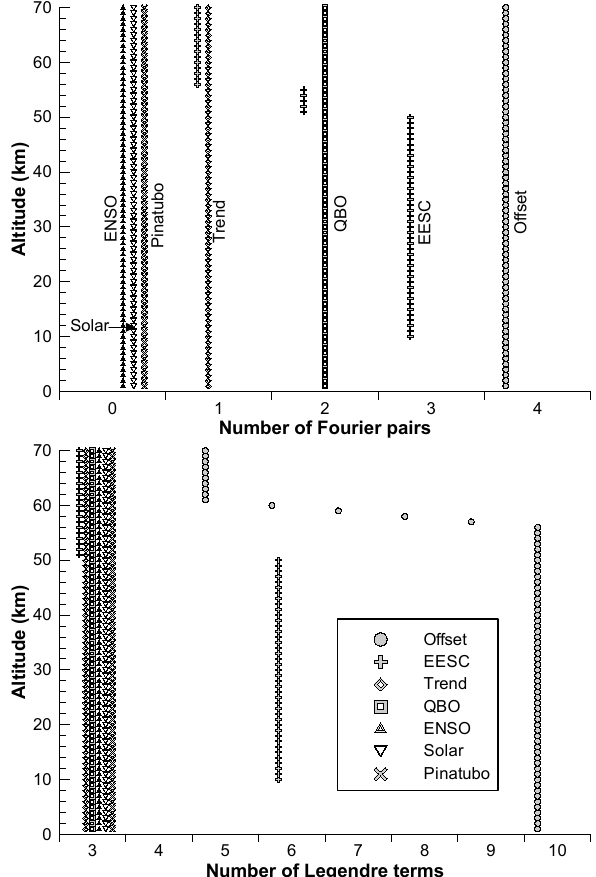
Figure 1. (a) The number of Fourier pairs ( N in Eq. 4) used to de- fine the perturbation pattern for each basis function fit coe ffi cient. If this value is zero then no seasonality is included in the perturbation pattern. (b) The number of terms included in the Legendre polyno- mial expansion of each X 2 i coe ffi cient in Eq. (4). Traces are o ff set slightly from one another to avoid overlap.